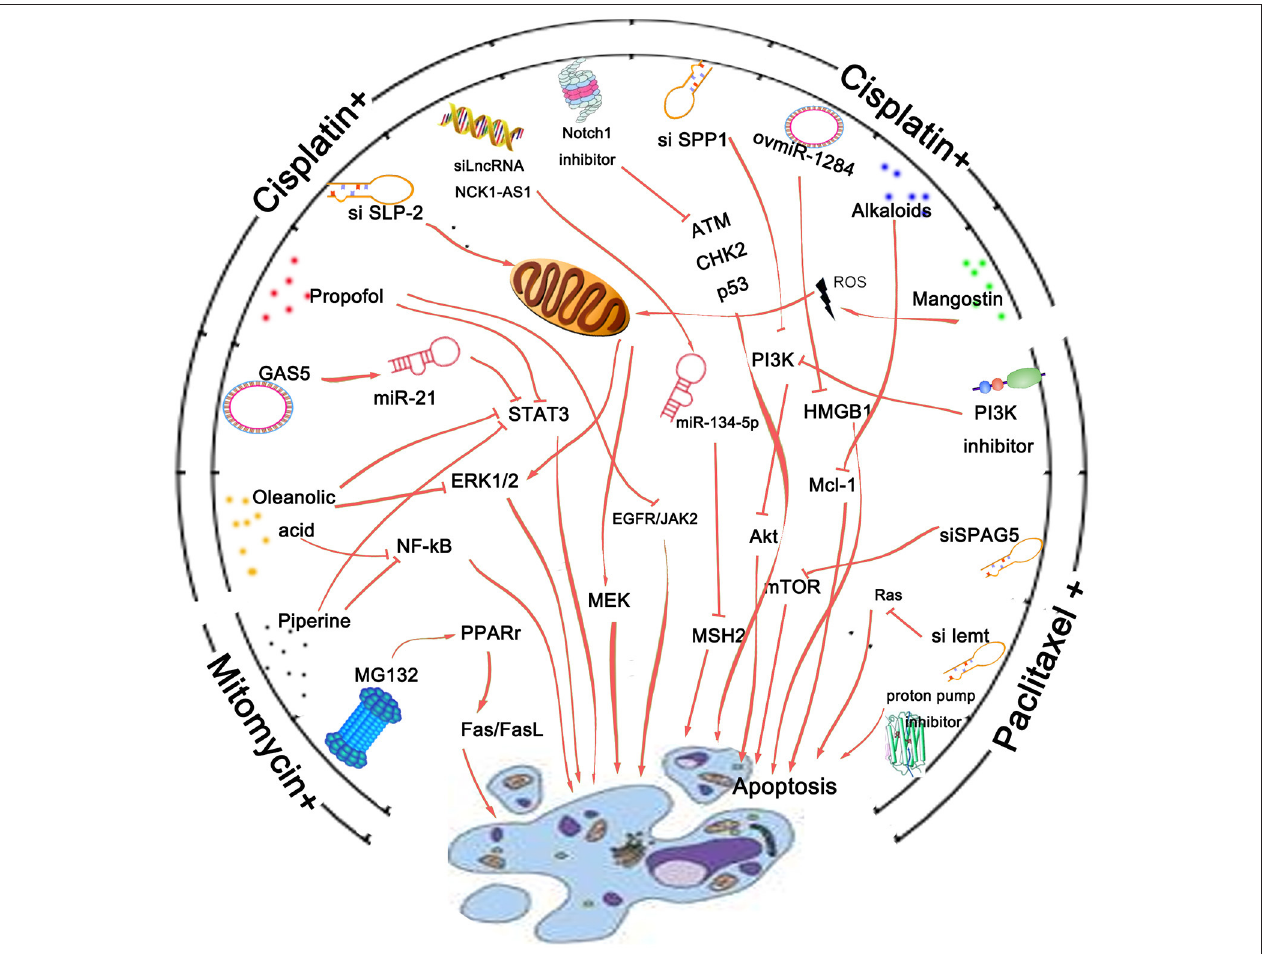
FIGURE 2 | Agents that could overcome drug resistance and increase the sensitivity of chemotherapy drugs by promoting cancer cell apoptosis. Cisplatin, mitomycin, and paclitaxel are three kinds of drugs commonly used clinically. Gene intervention is a pivotal technology used for cancer research. Regulation of crucial oncogene’s expression is reported to be involved in apoptotic process of cancer cells and thus enhance the sensitivity of chemotherapy drugs. Besides, inhibitors of key pathway molecules like Notch1 or PI3K are also reported to promote the anticancer effect of cervical cancer chemotherapy drugs. Many agents like substances derived from plants and protease inhibitors or proton pump inhibitor are found to possess a remarkable sensitization effect on cervical cancer cells to paclitaxel, cisplatin, or other conventional drugs by affecting the apoptotic process of cancer